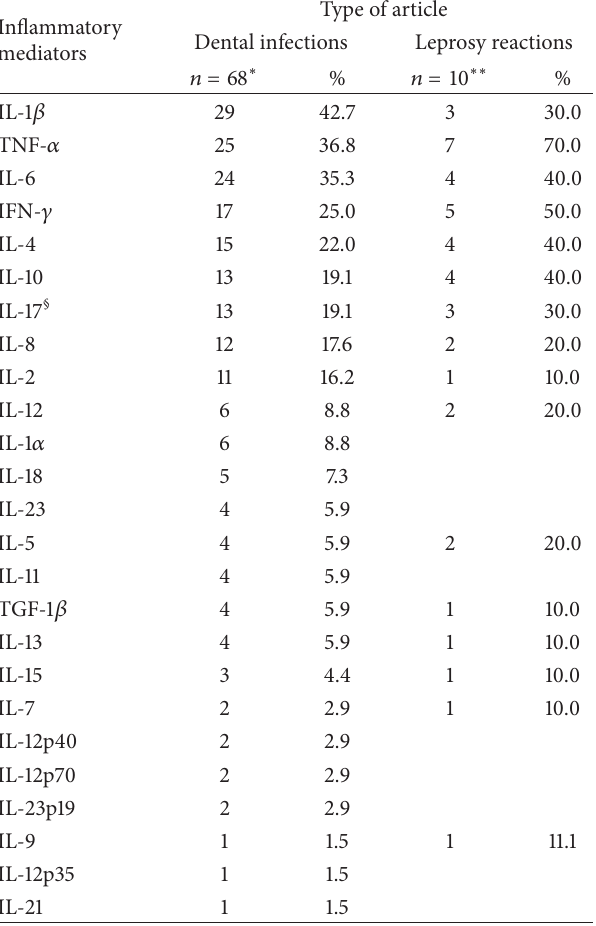
Table 1: Frequency of articles published between January 1, 1996, and December 31, 2013, that were selected for the systematic review regarding dental infections, leprosy reactions, and the types of investigated inflammatory mediators.